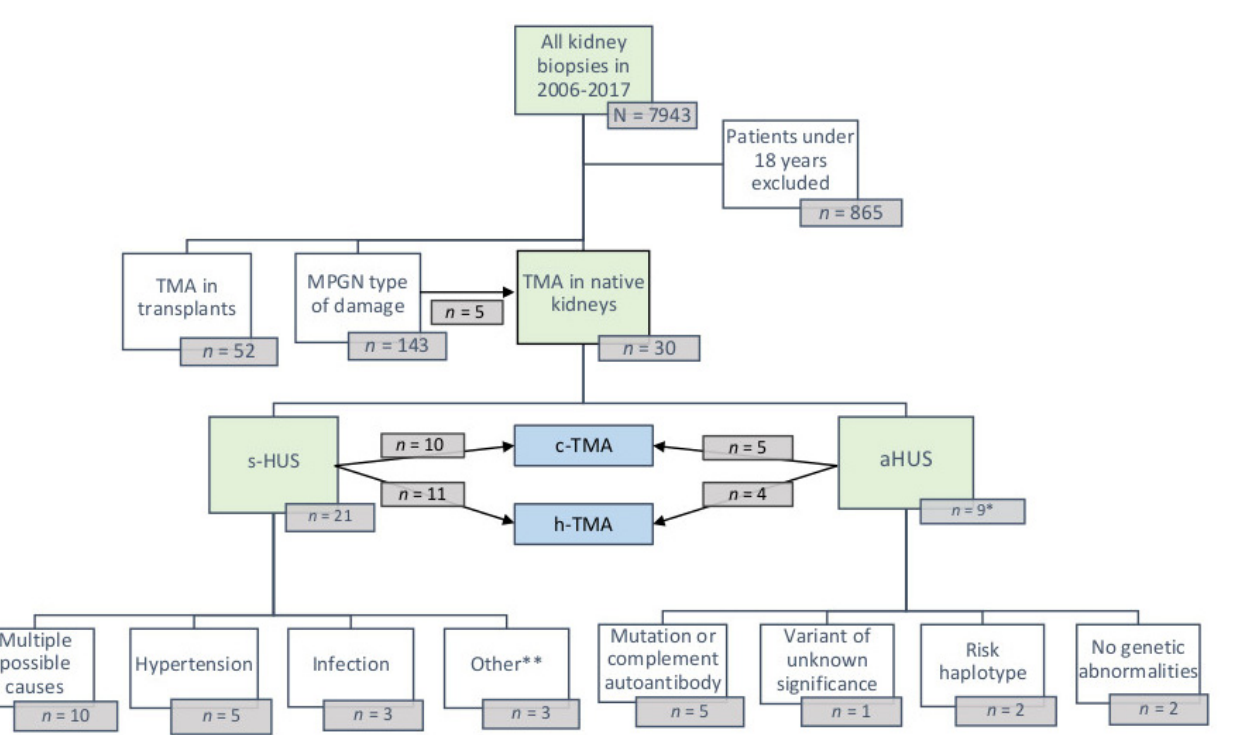
Figure 1. Study flow of the research. * Some patients are categorized twice based on the complement finding, ** malignant disease, and rheumatic disease.